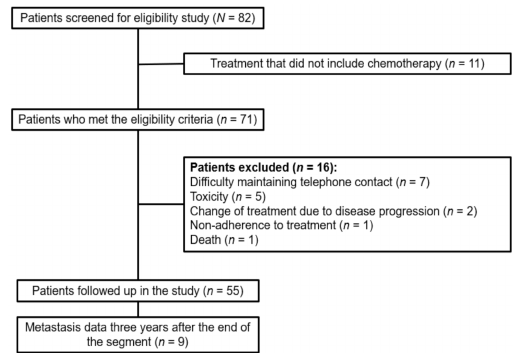
Figure 1. Diagram reporting the number of women with breast cancer screened, approached